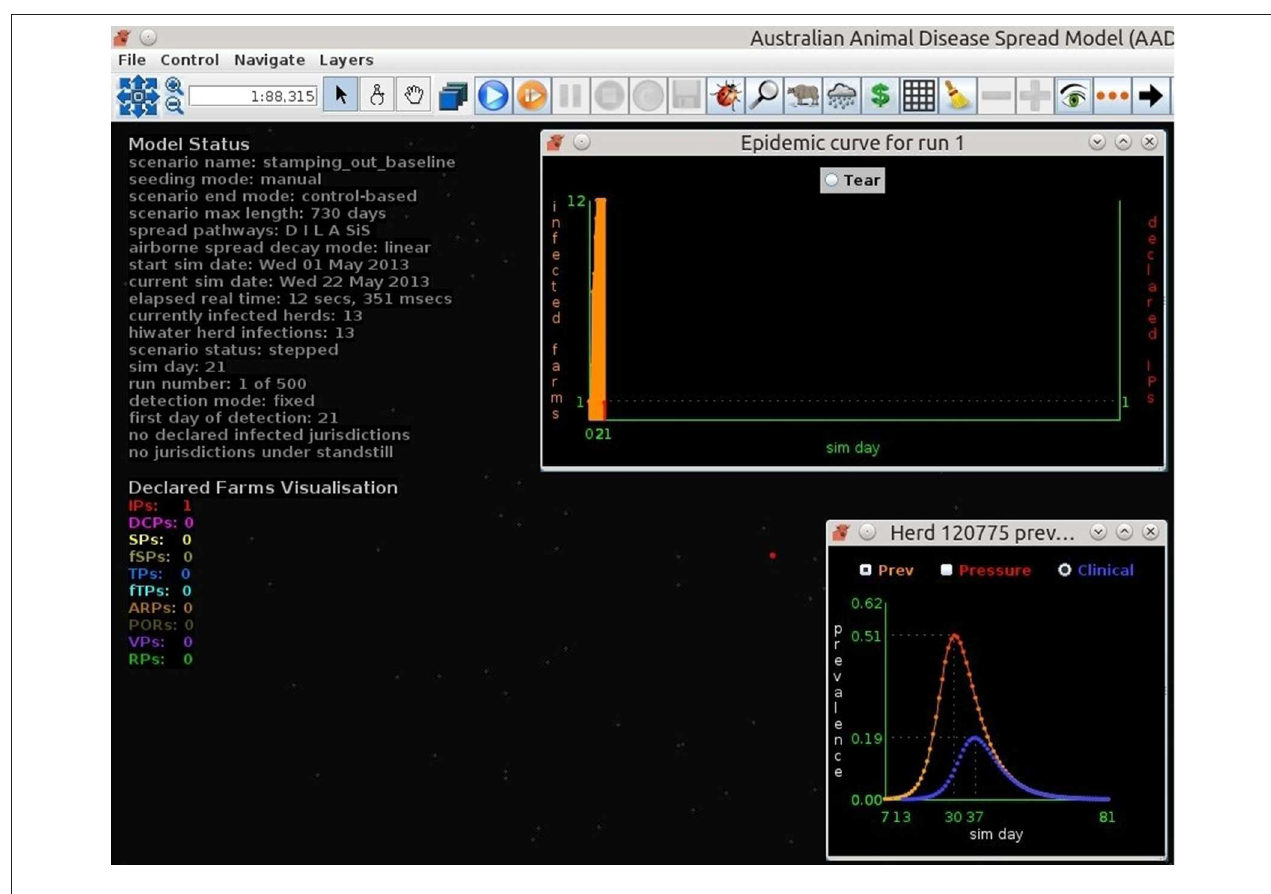
FIGURE 9 | Visualization of controlled premises.